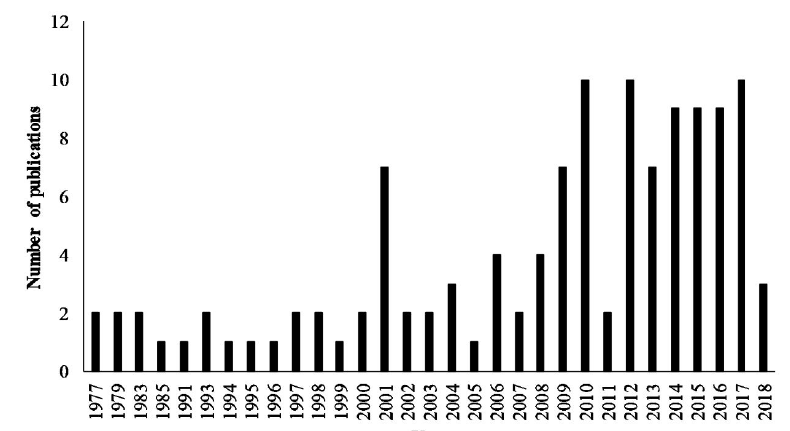
Figure 2. Number of publications produced containing morphological descriptions of eggs and larvae of freshwater fish in Brazil between 1977 and